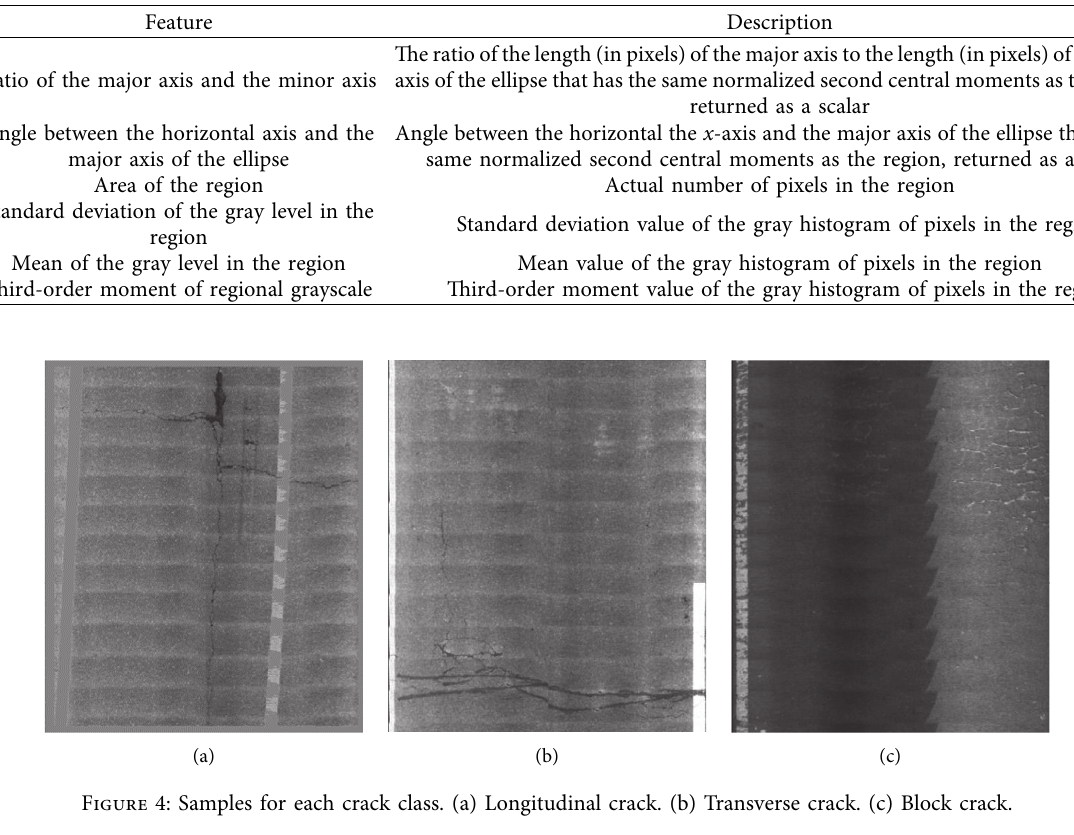
Table 1: Description of features.